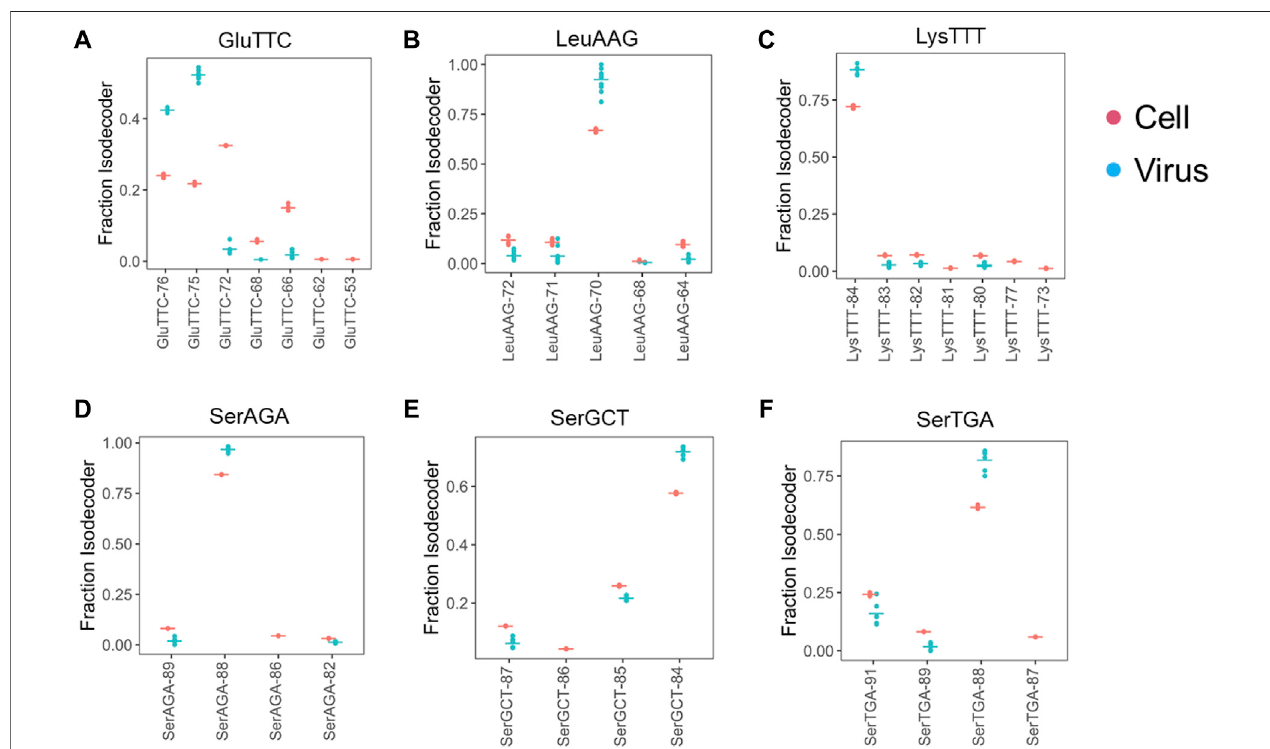
FIGURE 2 | Selective enrichment of tRNA isodecoders in SARS-CoV-2 viral preparations. tRNA isodecoder fractions from uninfected Vero cell ( n = 3, red) or cell free viral preparations ( n = 6, blue) are shown. Mean values are shown as a horizontal bar. Isodecoder nomenclature is according to the tRNAScan score of the Chlorocebus sabaeus tRNA genes identi fi ed in Rfam database. (A) tRNA Glu (TTC). (B) tRNA Leu (AAG). (C) tRNA Lys (TTT). (D) tRNA Ser (AGA). (E) tRNA Ser (GCT). (F) tRNA Ser (TGA).